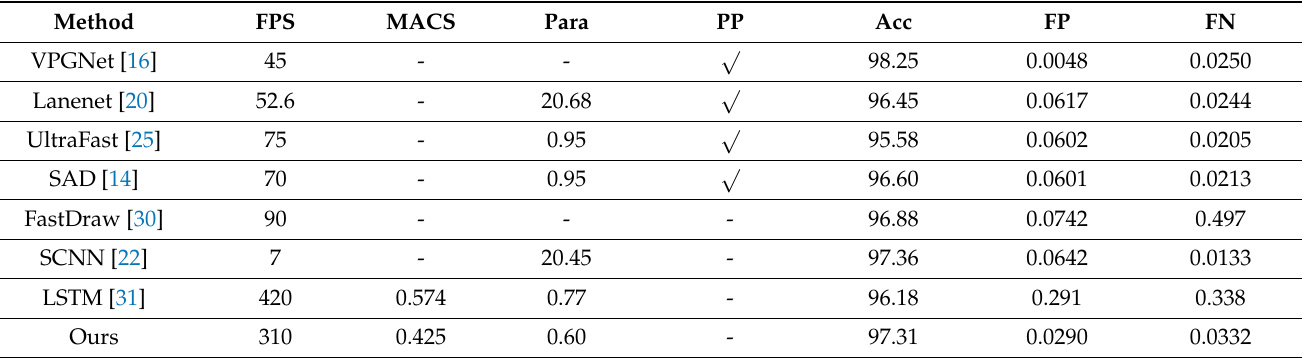
Table 1. Comparisons of accuracy (%) on TuSimple testing Set. The number of multiply-accumulate (MAC) operations is given in G. The number of parameters (Para) is given in M (million). The PP means the requirement of